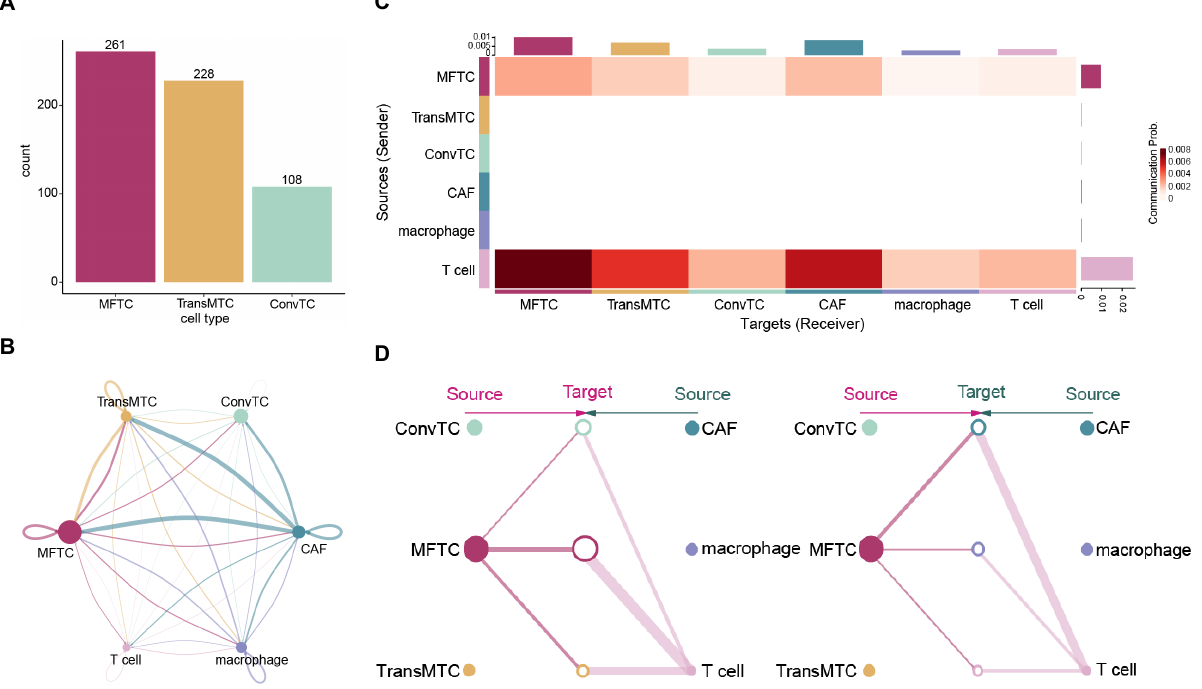
Figure 5. Cell–cell communication of major cell types and tumor sub-populations. ( A ) The total number of interactions from tumor sub-populations. ( B ) The number of interactions among distinct cell types. The thickness of the lines connecting cells indicates the number of interactions. The size of the circle indicates the number of cells. ( C ) Heatmap of the interaction between any two cell populations in the ADGRE5 signaling pathway. Bar plots on the right and top represent the total outgoing and incoming signaling strength, respectively. ( D ) The inferred ADGRE5 signaling network. The left and right plots display the autocrine and paracrine signaling to tumor sub-populations and other cell types, respectively. Solid and open circles represent the source and the target, respectively. The size of the circle indicates the number of cells. The thickness of the lines connecting cells indicates the interaction